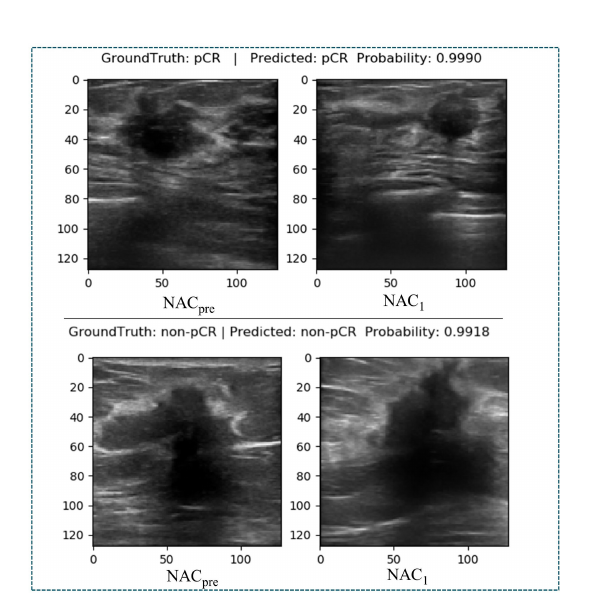
FIGURE 10 | Diagram of the ground truth and prediction results.